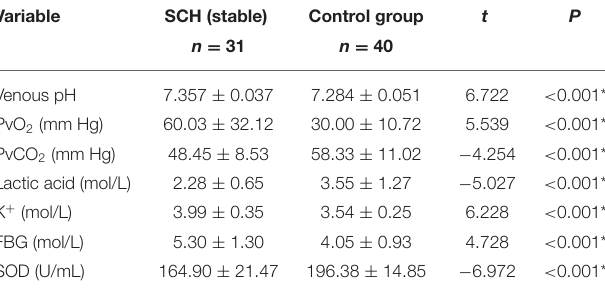
TABLE 9 | Comparison of effect indexes between stable SCH patients and control group (mean ± SD).